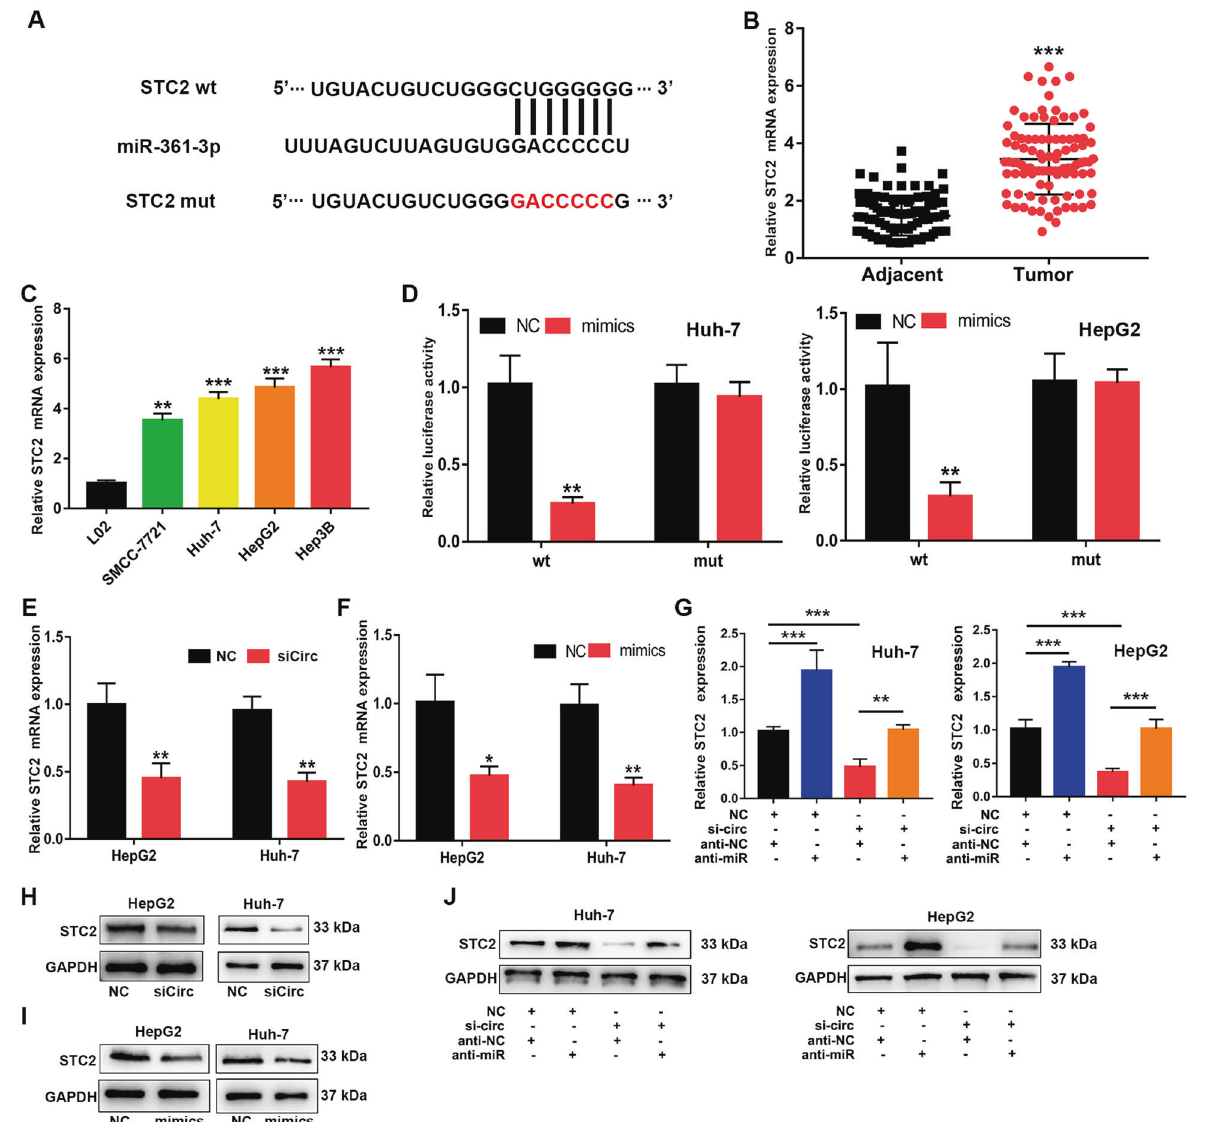
Fig. 5 STC2 is the target of miR ‐ 361-3p. A Bioinformatics tools indicated the complementary binding sites of miR ‐ 361-3p with STC2. B , C Relative STC2 expression in HCC tissues and cells. D Luciferase reporter assays showing the targeting of miR ‐ 361-3p with STC2 in Huh-7 and HepG2 cells. E – G qRT ‐ PCR showing STC2 mRNA expression in transfected Huh-7 and HepG2 cells. H – J Western blotting showing STC2 protein expression in transfected Huh-7 and HepG2 cells. Data ( n = 5) are the means ± SD. *P < 0.05, ** P < 0.01, *** P <